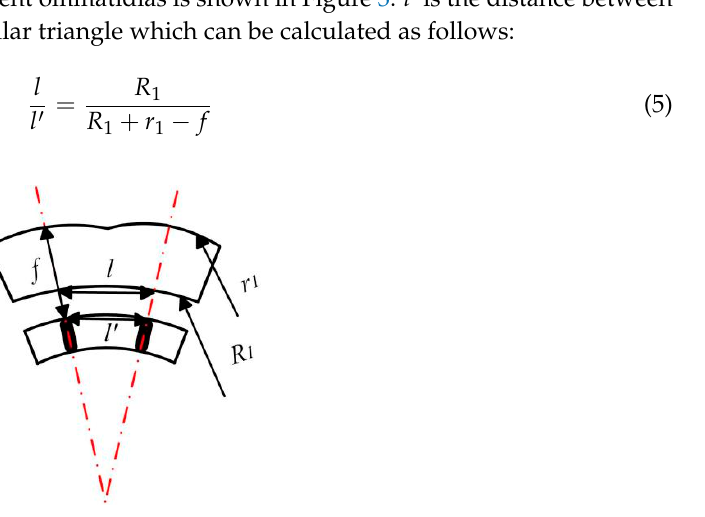
Figure 3. The positional relationship of adjacent ommatidias.